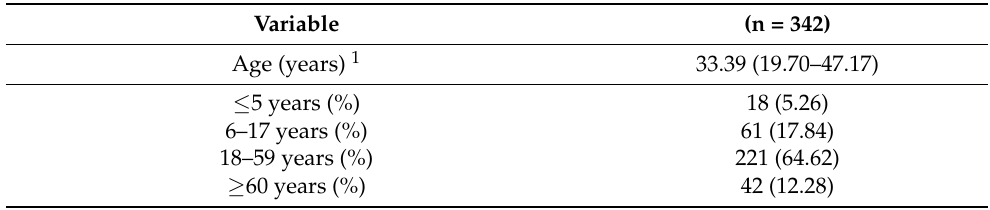
Table 1. Main variables. This table shows the demographic and clinical characteristics of the population